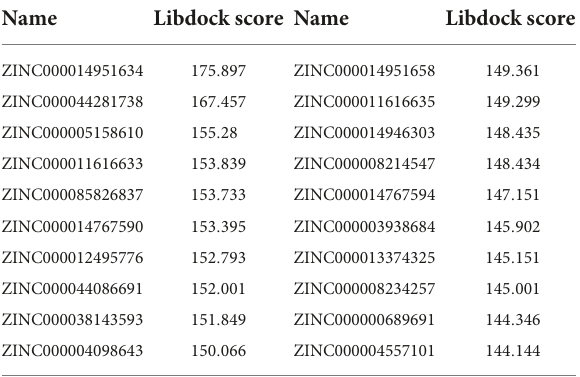
TABLE 2 Top 20 ranked compounds with higher LibDock